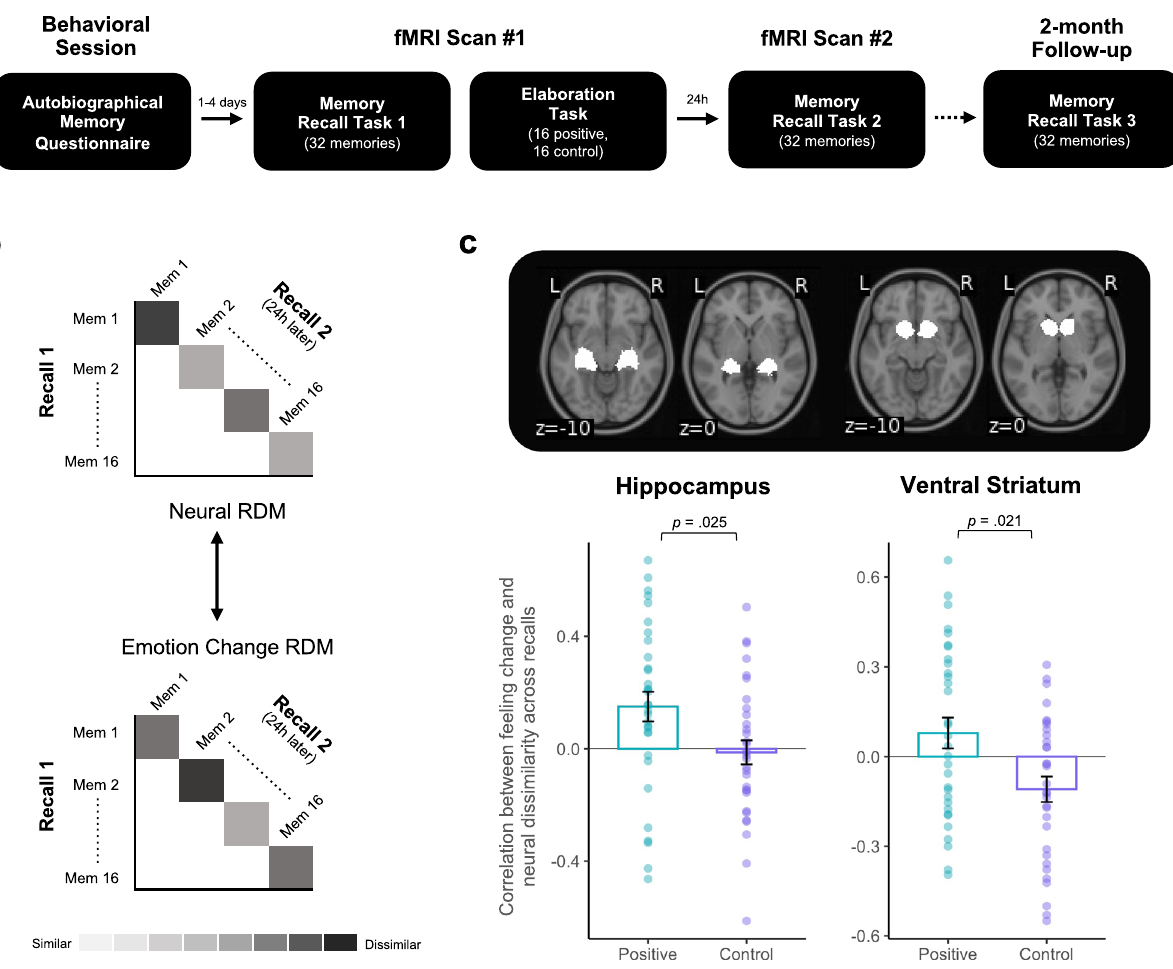
Fig. 5 Neural pattern dissimilarity across retrievals. Experiment 4: a Timeline; b Each neural RDM was correlated with its corresponding emotion change RDM across retrievals for each condition (positive, control). c We observed greater hippocampal and VS pattern dissimilarity across retrievals as a function of increasing positivity for memories that underwent positive elaboration relative to natural recall. Analyses were one-sample sign permutation tests (5000 iterations) on the difference in spearman rho values between conditions. Overlaid dots represent individual participants. Bars show mean values per condition across participants ( n = 32); error bars = ± SEM. Source data are provided as a Source Data fi